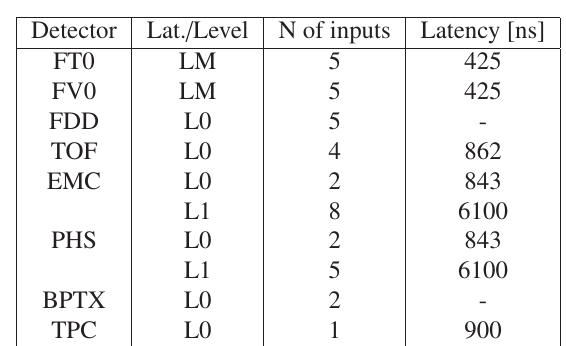
Table 1. CTP trigger inputs with their latency and contributing trigger